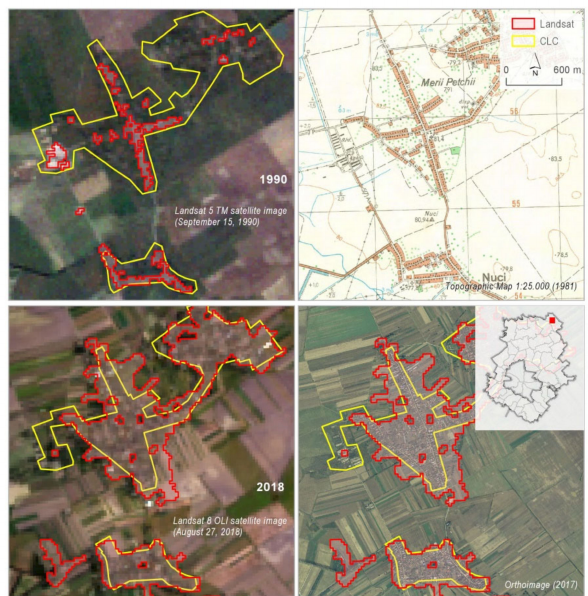
Figure 11. Comparative mapping of change in the built-up area (1990 / 2018) in Merii Petchii and Nuci villages, on the northeastern edge of Ilfov County. Landsat TM (1990) and OLI (2018) imagery from USGS, topographic map (1981) from the DTM (Military Topographical Directorate) and aerial orthophotos (2017) by ANCPI (National Agency of Cadastre and Land Registration).